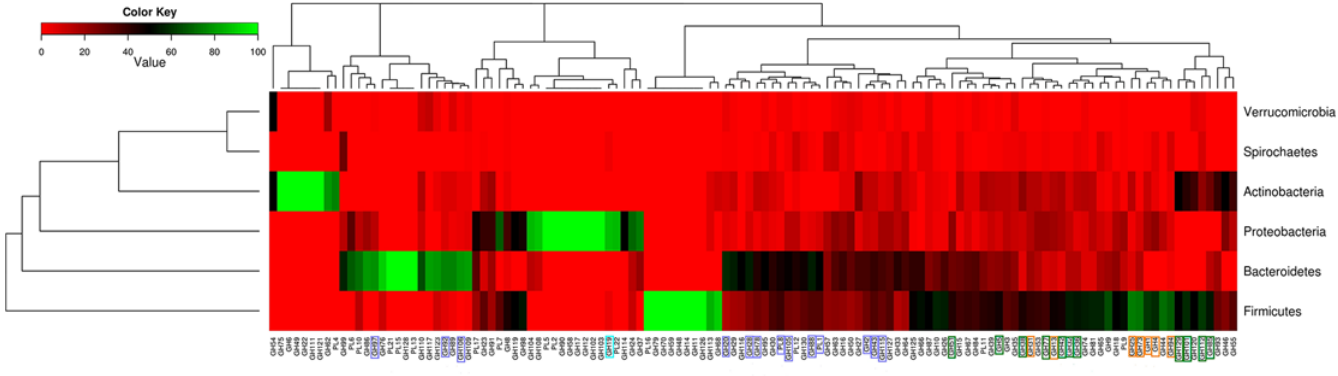
Fig 7. Phylum specific signatures of CAZyme family abundances. Heatmap of relative percentage abundance of the different digestive CAZyme families across top contributing phyla. The marker CAZyme families identified significantly abundant in the CAZotype-1, CAZotype-2 and CAZotype-3 are highlighted in Blue, Orange and Green text boxes, respectively. Distinct phylum specific signatures in the abundances of different CAZyme families are observed. Further, mapping of marker CAZyme families of the three CAZotypes on to the heatmap indicates that enzymes specific to each CAZotype show distinct phylum specific abundances. For example, a driver enzyme from CAZotype-1 maps perfectly well in the ‘ Bacteroidetes specific ’ region of the heatmap.